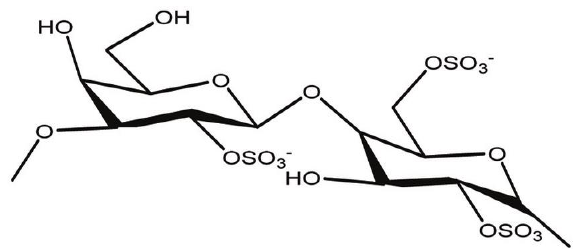
Figure 1. The molecular structure of carrageenan.